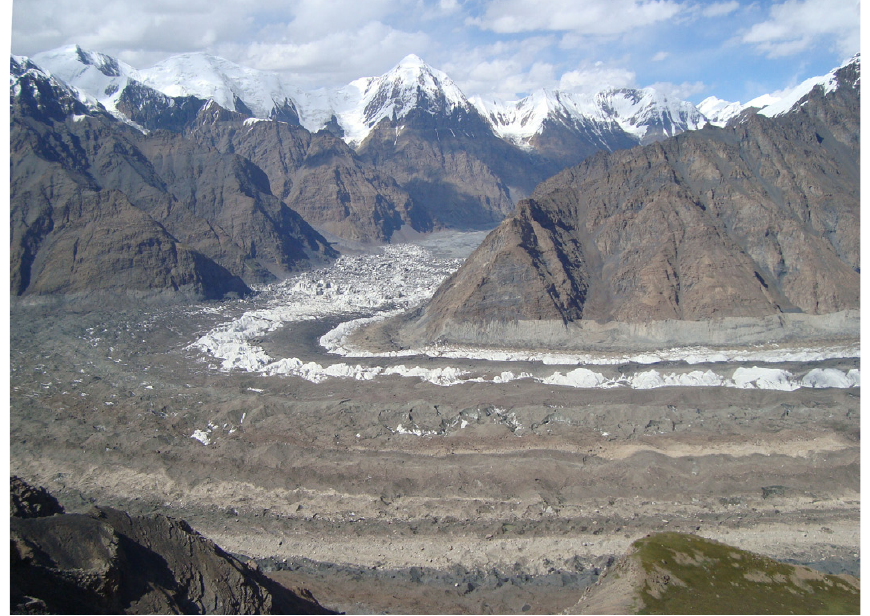
Figure 2. Bending area of Southern Inylchek showing the different parallel aligned debris layers and two bare ice ramps. In the background, the drained area of Lake Merzbacher is visible, which holds grounded icebergs. The picture was taken during a fieldwork session carried out at the Global Change Observatory “Gottfried Merzbacher” on 28 July